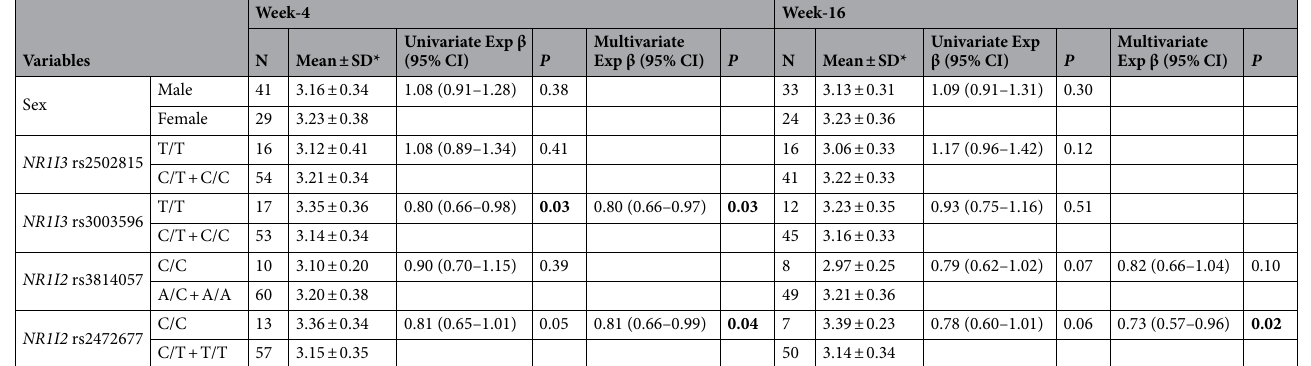
Table 3. Regression analysis for NR1I3 and NR1I2 variants on mean log plasma EFV concentrations at week-4 and week-16 after initiation of EFV-based ART [ * —Mean of log plasma EFV concentrations (ng/mL) and the standard deviation (SD); ART—Antiretroviral therapy; CI—Confidence interval; EFV—Efavirenz; N— Number; P — P -value]. Significant values are in [bold].